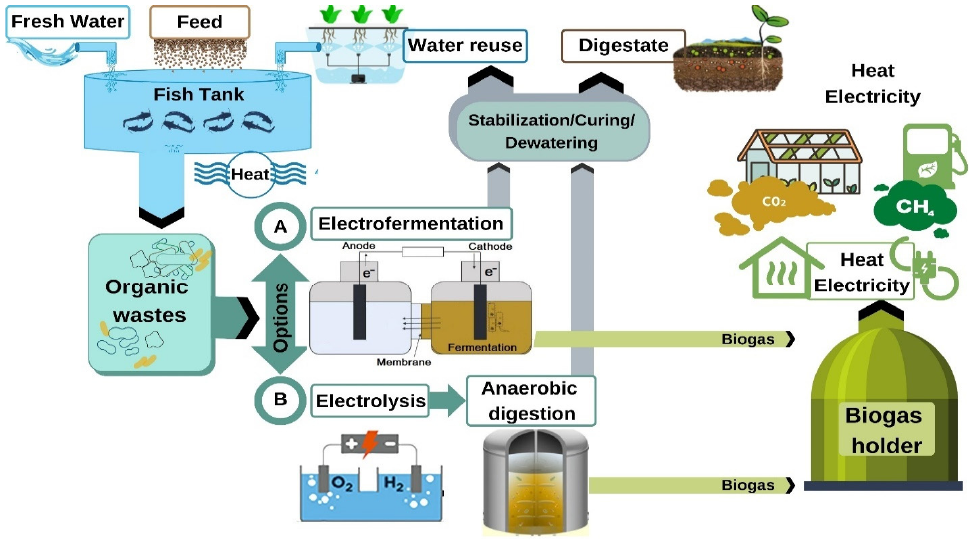
Figure 7. Technological solutions for the complex processing of waste from the life cycles of the clariid catfish with the production of useful bio-based products.